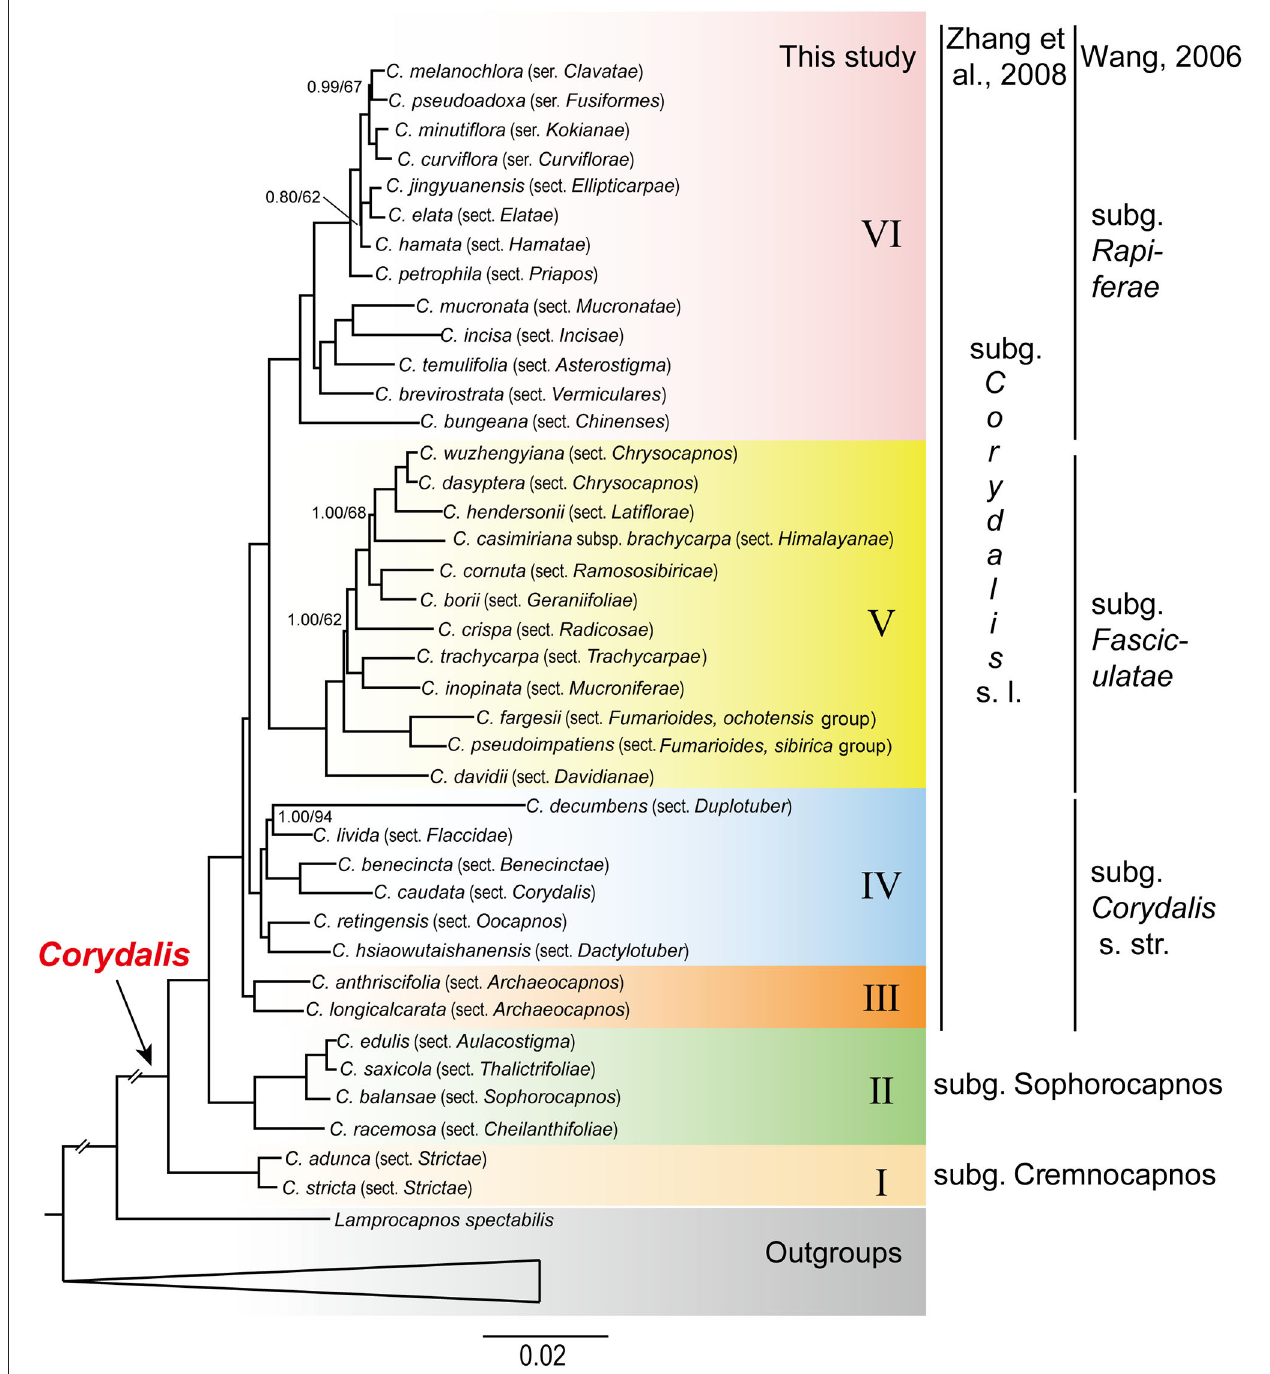
FIGURE 1 | Phylogenetic tree conducted using BI methods. The numbers above branches represent BI posterior probability and ML bootstrap support, respectively. Clades have PP-value of 1 and BS-value of 100, unless otherwise indicated. The circumscription of subgenera just differed for clade III + IV + V + VI, the left was by Zhang et al. (2008), while the right was by Wang (2006).